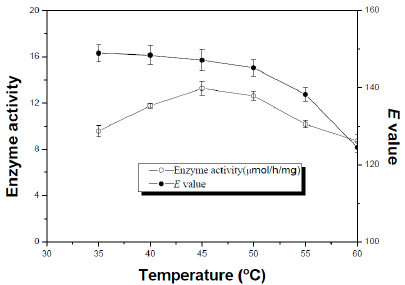
Figure 4. Effects of temperature on the enzymatic esterification of ibuprofen. Reaction conditions: the reactions were carried out in n -heptane (10 mL, a w 0.21) with racemic ibuprofen (0.2 mmol), 1-octanol (0.2 mmol) and the immobilized APE1547 powder (160 mg) at different temperature. The ultrasound power was 225 W.